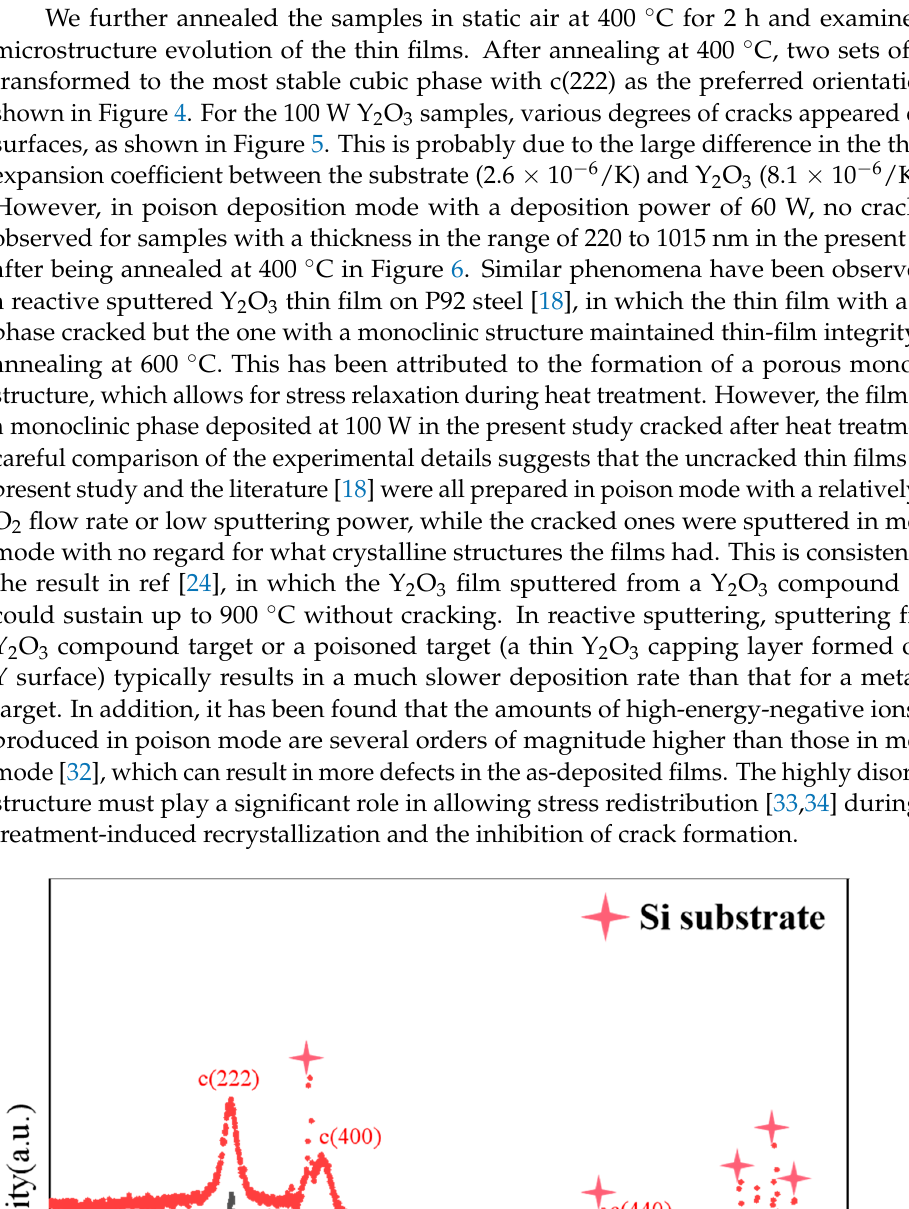
Figure 4. The XRD patterns of Y 2 O 3 films (samples 1-3 and 2-3) annealed at 400 °C.